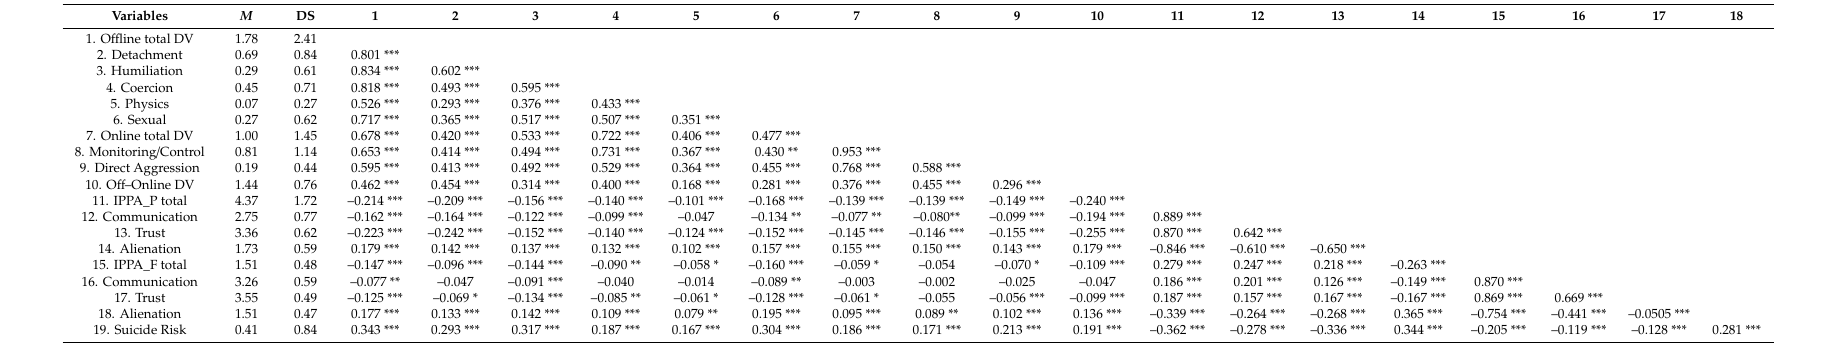
Table 3. Partial Correlations between O ff - and Online DV, IPPA-P, IPPA-F and Suicide